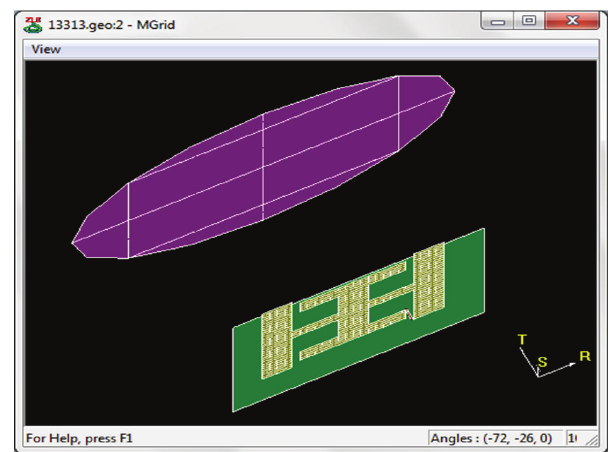
Figure 5: 3D view of proposed antenna.